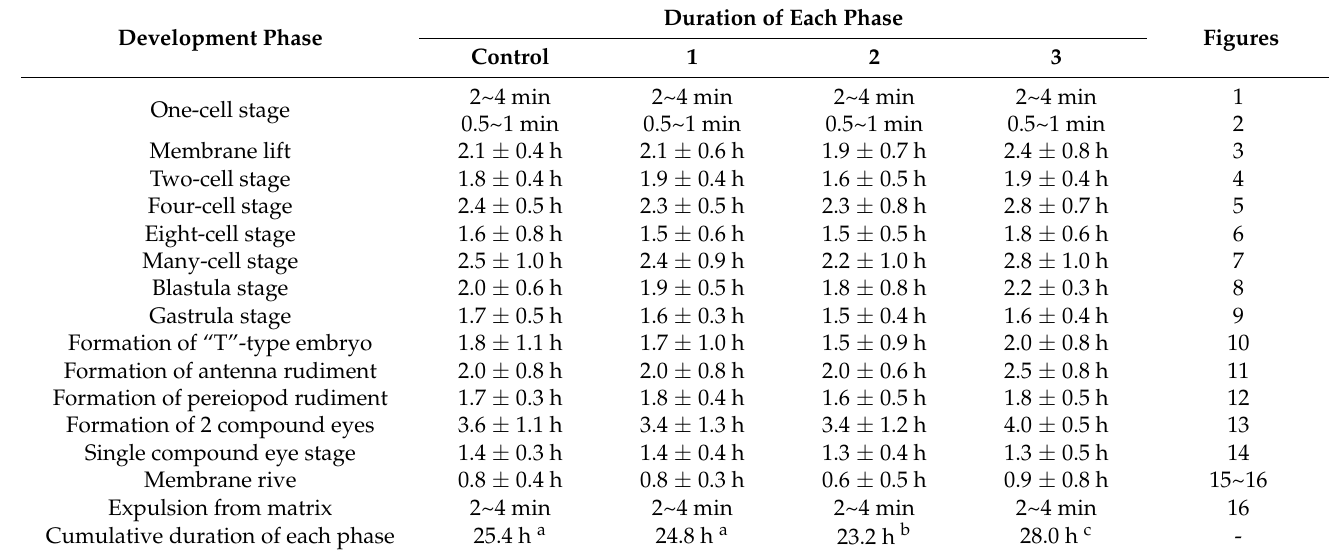
Table 3. The effect of salinity on intrinsic rate of increase, generation time, net reproductive rate and finite rate of increase in S. mucronata